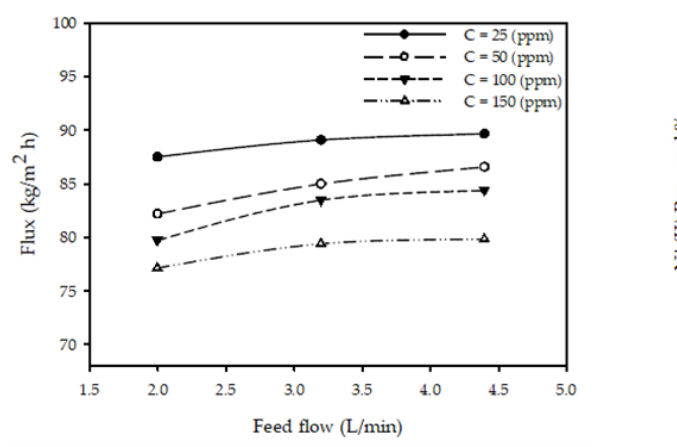
Figure 4. Feed concentration impact on ( a ) permeate flux and ( b ) Ni (II) removal % for feed flow rates with a constant pressure of 20 bar and a temperature of 45 °C.